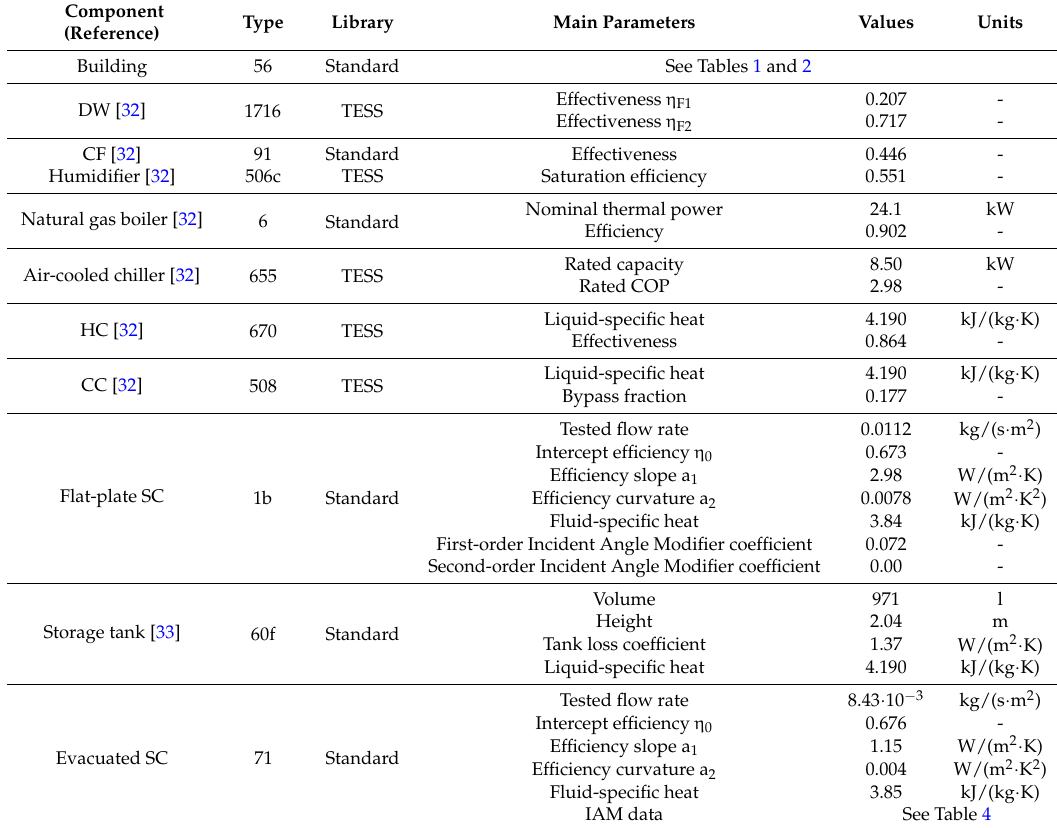
Table 3. Main models used for the simulation and their main parameters. DW: desiccant wheel; TESS: Thermal Energy Systems Specialists; CF: cross-flow heat exchanger; COP: coefficient of performance; HC: heating coil; CC: cooling coil; SC: solar collector; IAM: incident angle modifier.